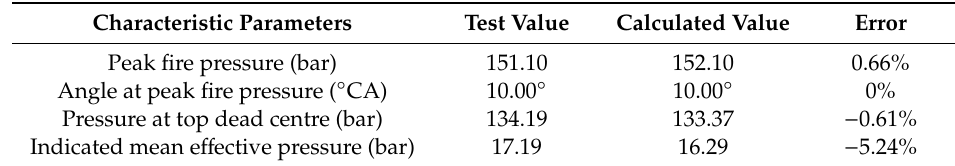
Figure 3. Comparison of the cylinder pressure curves of the calculation and routine tests. Table 2. Comparison of the characteristic parameters of the cylinder pressure’s calculation and routine test.